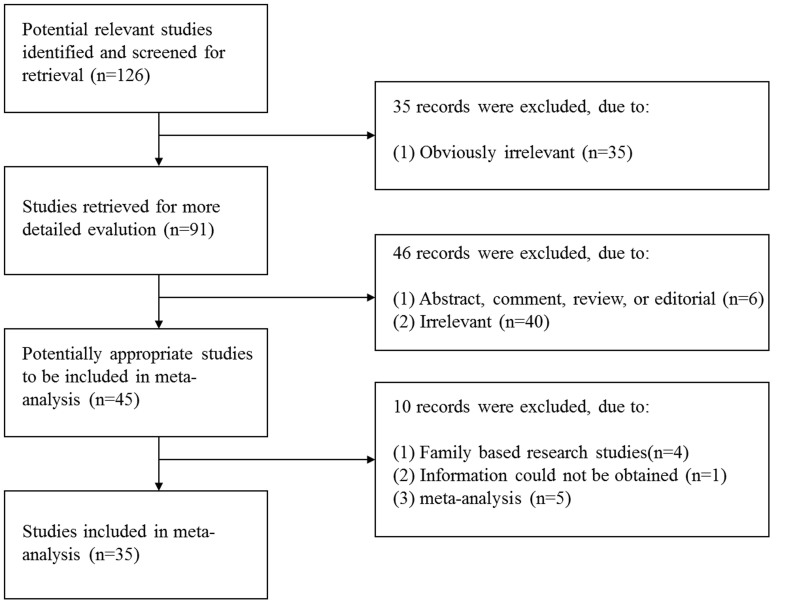
Flow chart of the study selection process and specific reasons for exclusion from the meta-analysis.